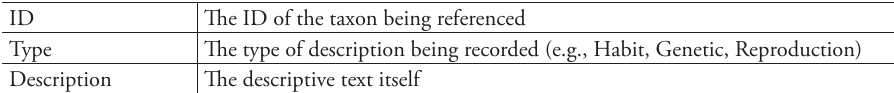
Table 3. Description table - One row per description per